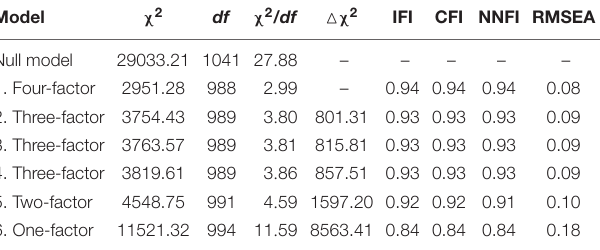
TABLE 2 | Results of confirmatory factor analysis of the study